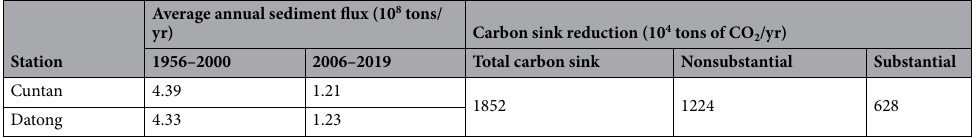
Table 3. Reduction in the carbon sink caused by the reduction in sediment transport in the reach between Cuntan Station and Datong Station after 2006.